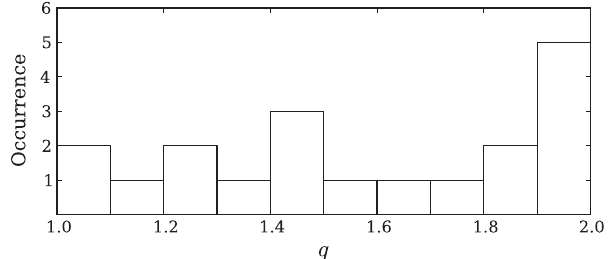
FIG. 4. Histogram of parameters selected by the greedy algorithm for the reduced basis of Fig.